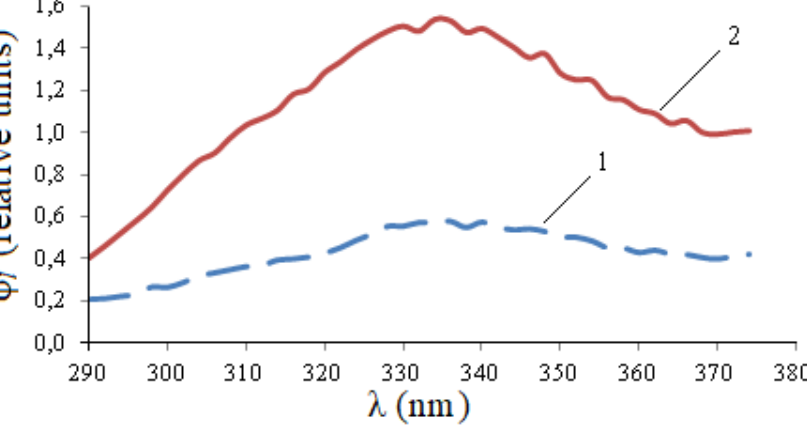
Figure 3. Spectral characteristics of luminescence of wheat seeds at λ e,1 = 232 nm: 1 — not infected, 2 — 98% infected.